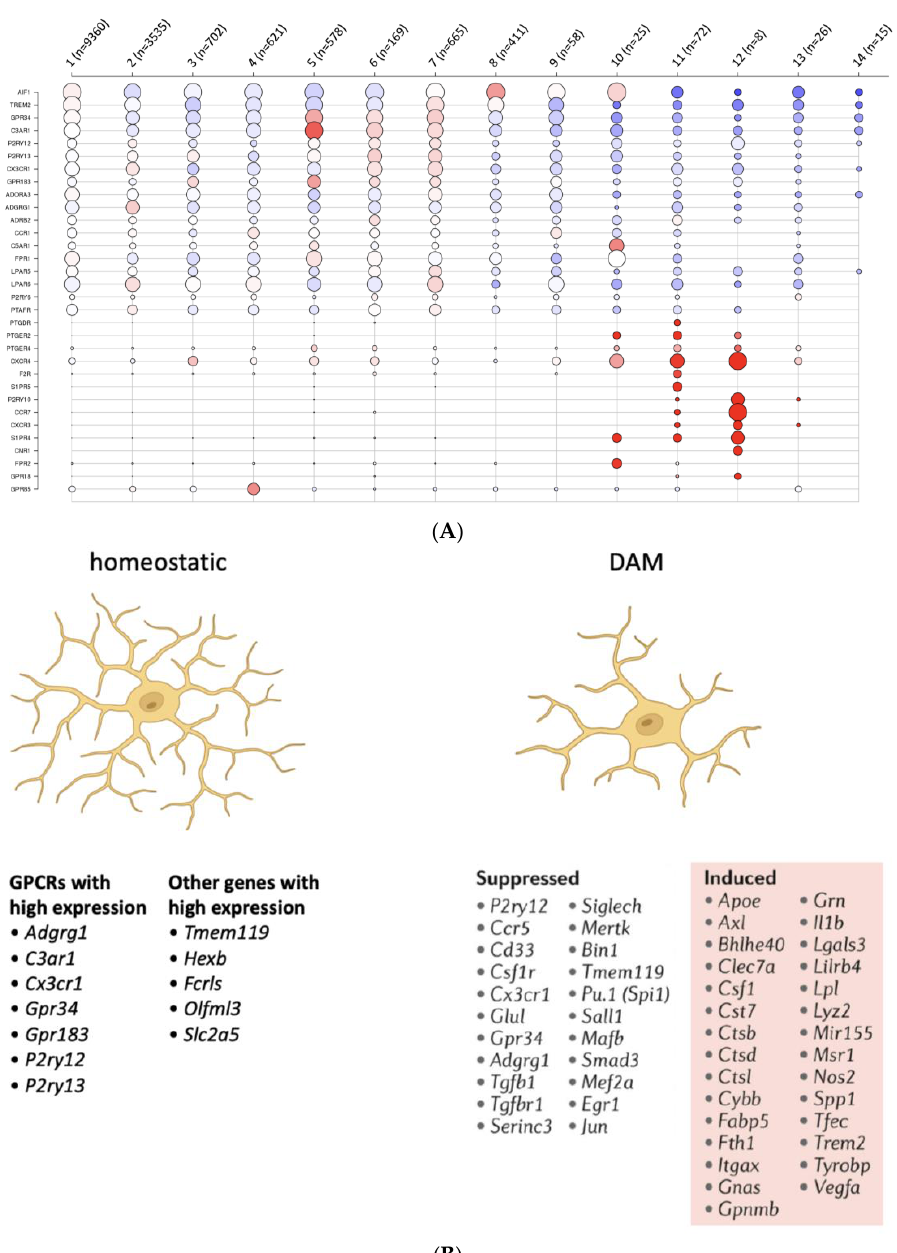
Figure 2. Expression of GPCRs and other selected genes in homeostatic microglia and disease-associated microglia (DAM). ( A ) Single-cell RNA sequencing and clustering of the mRNA expression pattern revealed 14 subpopulations of human microglia cells [58] . These subpopulations are equipped with different subsets of GPCRs and P2Y 12 is found in all microglial subpopulations. Significantly expressed GPRCR mRNAs are shown (red = high, blue = low expression, and circle size reflexes the portion of the cells in the cluster expressing the gene). As references, the microglial markers IBA1 (AIF1) and TREM2 are given at the top of the list. ( B ) The homeostatic (resting) microglia express more than 30 GPCRs, and the receptors with the highest expression are listed. Together with additional genes (e.g., Tmem19, Hexb) these GPCRs are considered marker genes for homeostatic microglia. Transcriptome studies of microglia from patients and mouse models of neurodegenerative diseases revealed changes in the expression of some of these marker transcripts. This information is taken from different RNA sequencing studies